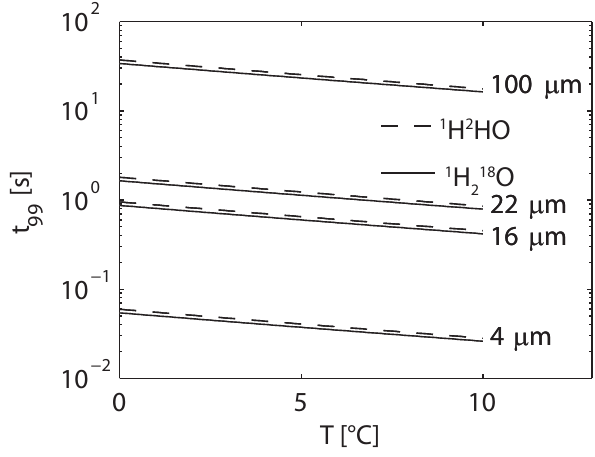
Fig. 2. Time required for a single spherical cloud droplet to reach 99 % isotopic equilibrium (both for δ 2 H and δ 18 O) with the surrounding vapor at air temperatures prevailing at Schm¨ucke. t 99 is depicted for four different droplet diameters: 22µm, 16µm and 4 µm corresponding to the cut-off sizes of the three stages of the CASCC, and 100µm which we assume to be the diameter of the largest droplets that enter the CASCC. D k values ( k = 1 H 2 H 16 O, and 1 H 218 O) were deduced from the relations to D 1 (Cappa et al., 2003), and D 1 H 216 O was derived from campaign temperature and the air pressure value (900hPa) using the relation presented by Hall and Pruppacher (1976).